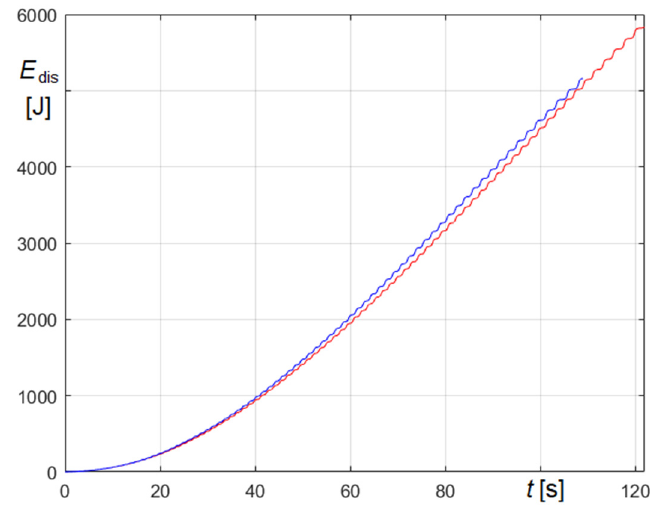
Figure 28. Comparison of the dissipated energy − time curves in the transient phase of damped forced oscillations by using M e 1 forcing function (blue line) and M e 2 forcing function (red